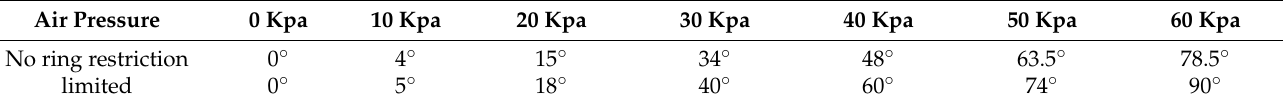
Figure 10. Comparison of simulation results of driving joints. Table 2. Drive joint simulation analysis test data.